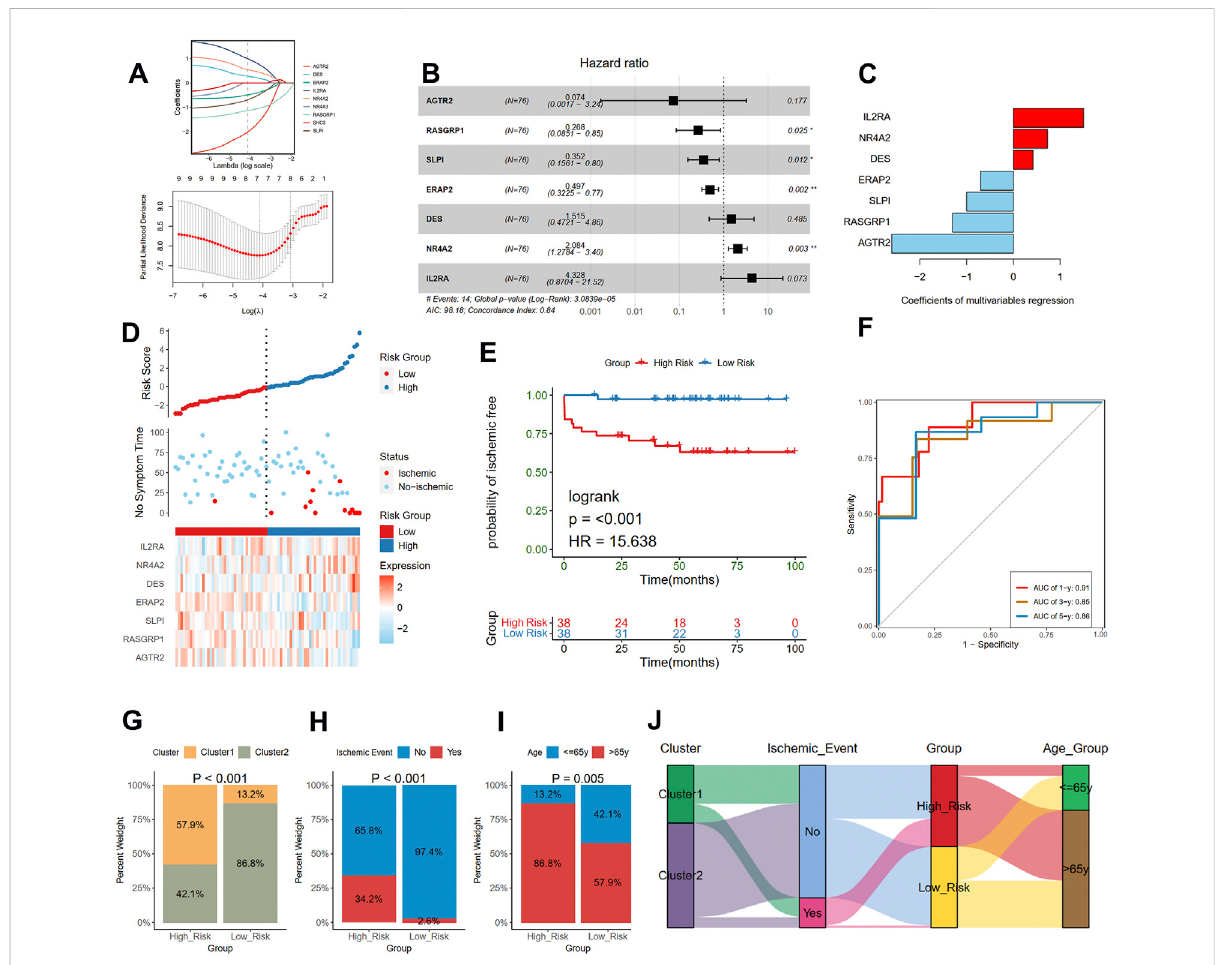
FIGURE 7 Construction of a risk model in the training cohort. (A) Feature selection by LASSO regression (down) and the coef fi cients change of different genes with different lambda (up). (B) Multivariate Cox regression depicted with a forest plot. (C) The coef fi cients of selected seven genes in multivariateCoxregression. (D) Distributionofriskscore(up)andischemicstatus(middle)ofatheroscleroticpatientsinthehighandlow-riskgroups, and heat map (down) illustrating the expression patterns of the seven model genes in the two groups. (E) Survival curve of the atherosclerotic patients in the two groups. (F) Time-dependent ROC curve of the risk model. A histogram shows the relative proportion of different clusters (G) , ischemic event (H) , and age group (I) in two risk groups. (J) A Sankey diagram showing the distribution of different